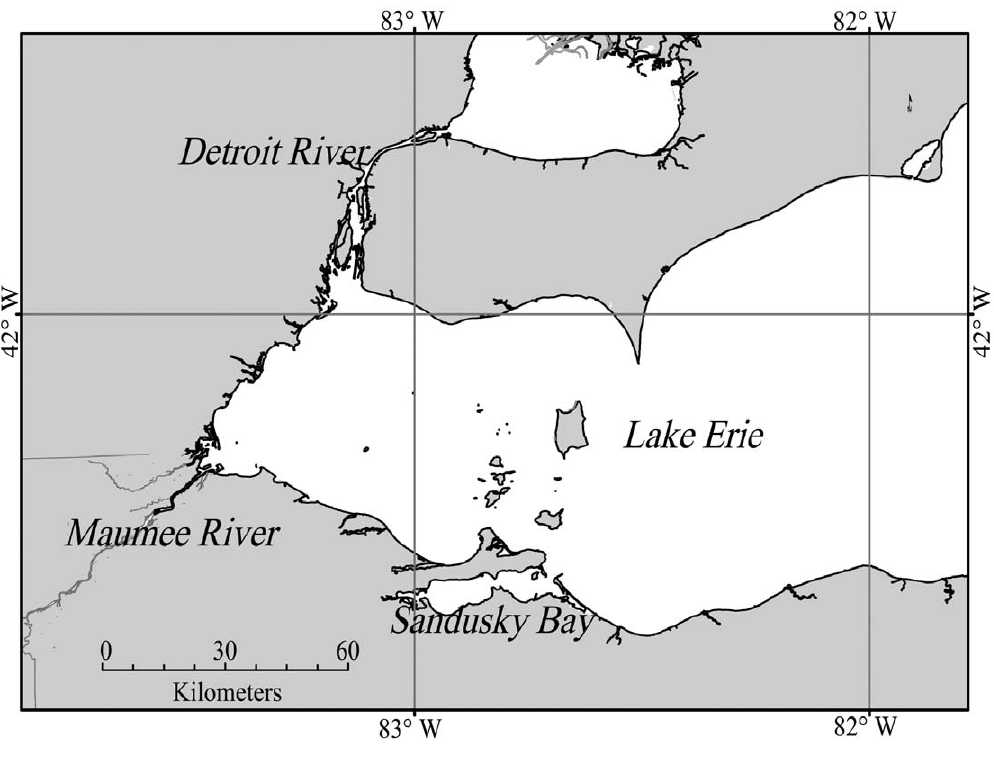
Figure 1. Map of western Lake Erie.